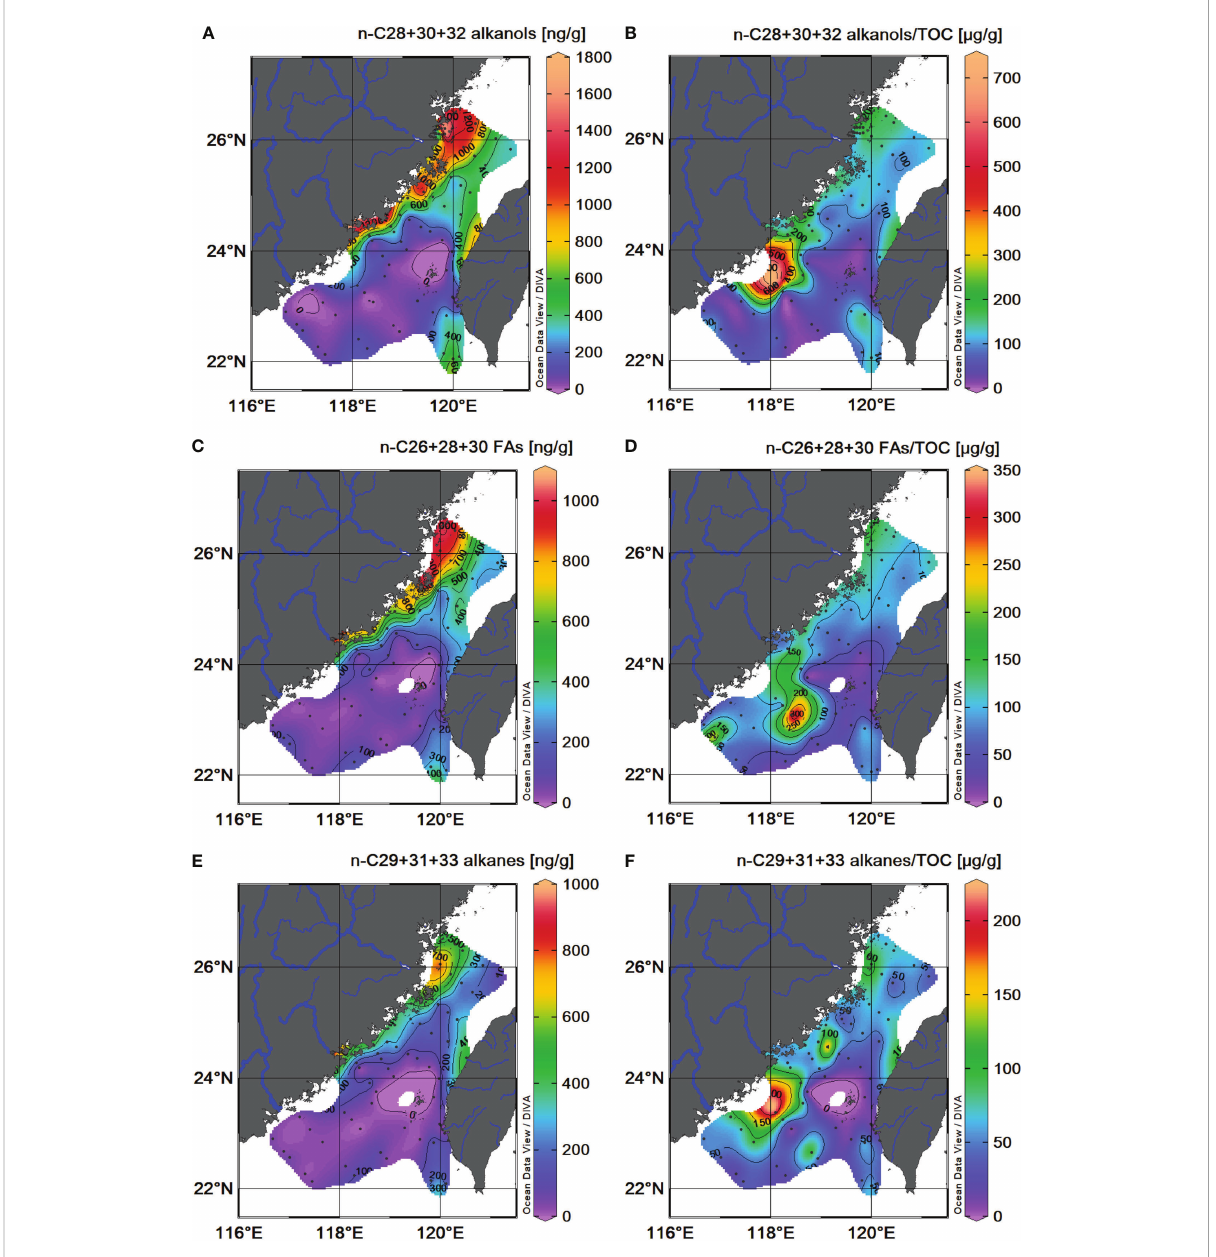
FIGURE 4 Spatial distributions of terrestrial biomarkers in TS surface sediments. Sediment dry weight and TOC-normalized n -C 28+30+32 alkanol content (A, B) ; n -C 26+28+30 FA content (C, D) ; n -C 27+29+31 alkane content (E, F)